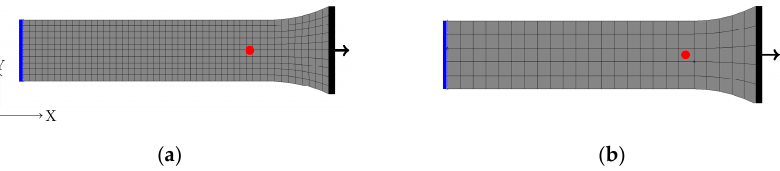
Figure 3. A 3D FE model of the dog bone specimen (ISO 527-2, Type 1A with a total length of 170 mm and a cross section of 10 × 4 mm 2 ) using symmetry in the x-direction. The left-hand side of the specimen (blue) is fixed, and the right-hand side (black) is subjected to a displacement with kinematic coupling functionality. The red point, which is 35 mm from the symmetry plane, indicates the point where local displacement is measured. ( a ) MS = 1 mm (1960 elements); ( b ) MS = 2 mm (250 elements). Based on the identified hardening curves, a single mathematical expression was derived to express the entire HC.